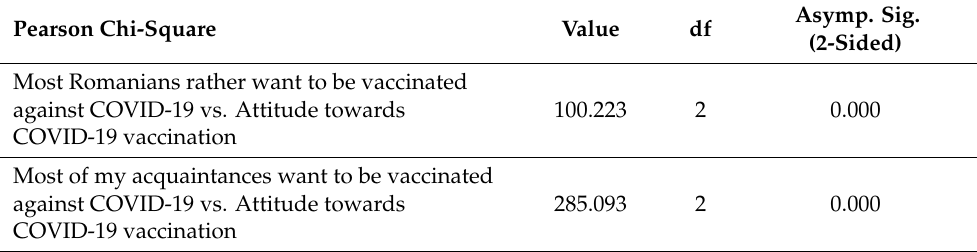
Table 1. Results for the chi-square